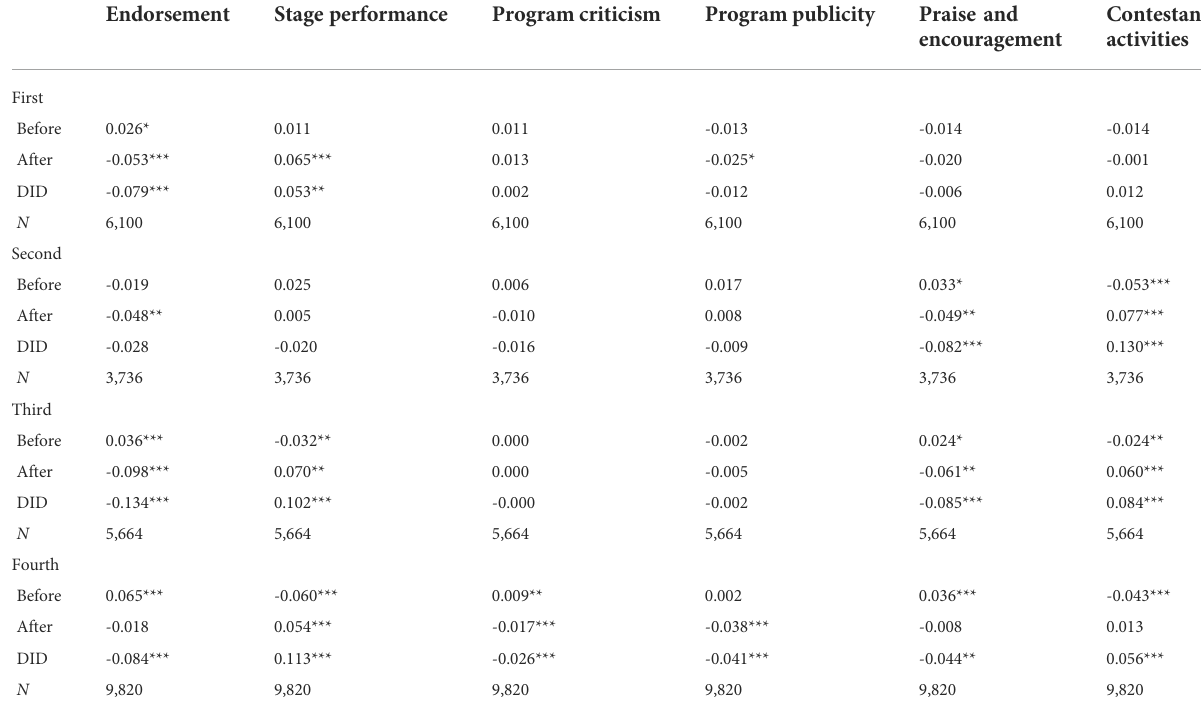
TABLE 3 DID regression results for post topics for four elimination matches.